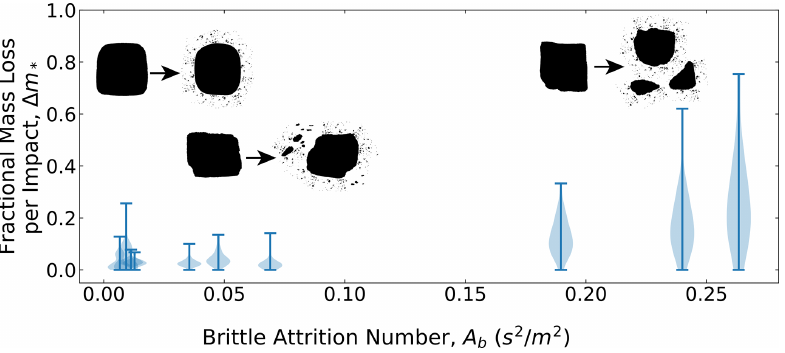
Figure 7. Violin plots illustrating the size distribution of resulting particle fragments. The fractional mass loss per impact ( (cid:49)m ∗ ) was mea- sured for all impacts; this result is displayed as a violin plot for each material strength. Example parent and daughter particles are displayed for strong, intermediate, and weak materials to illustrate typical breakdown products after an impact or series of impacts. Mechanically weak particles (higher A b ) produced fragments in a wide range of sizes and weights, while mechanically strong particles (lower A b ) generated a narrow distribution of chip sizes. This transition occurs around A b = 0.1s 2 m − 2